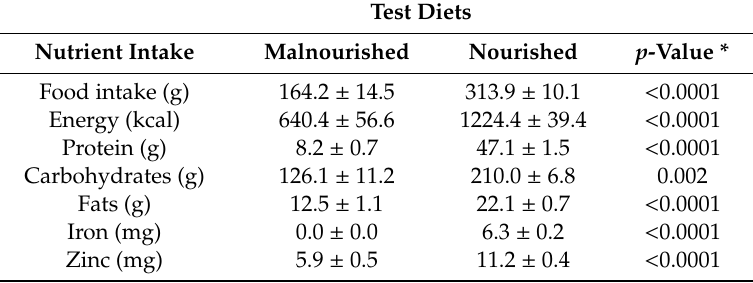
Table 2. Comparison of food and nutrient intake during 21 day feeding in baseline rats 1